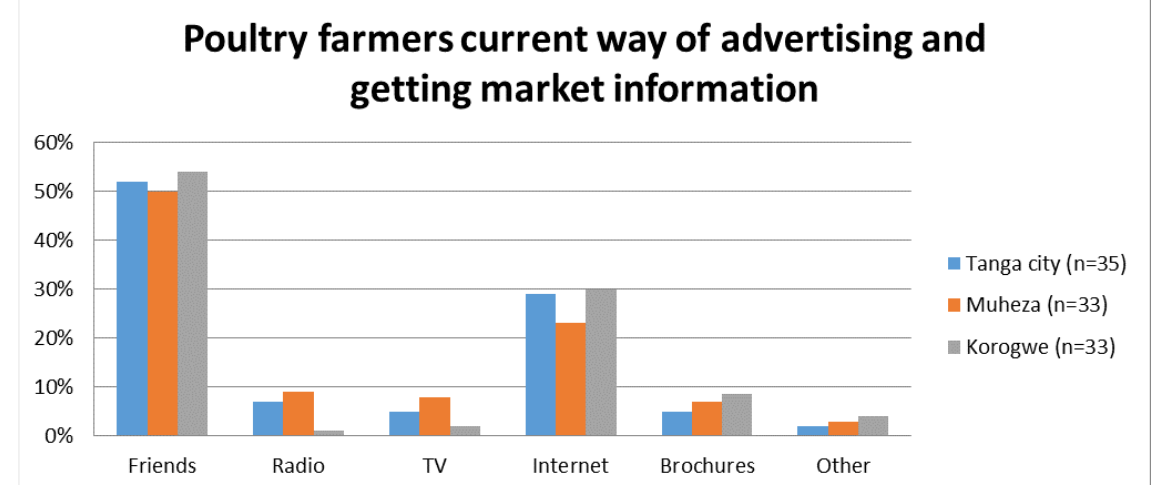
Figure 3. Description of current way of advertising and getting market information by poultry farmers and buyers,